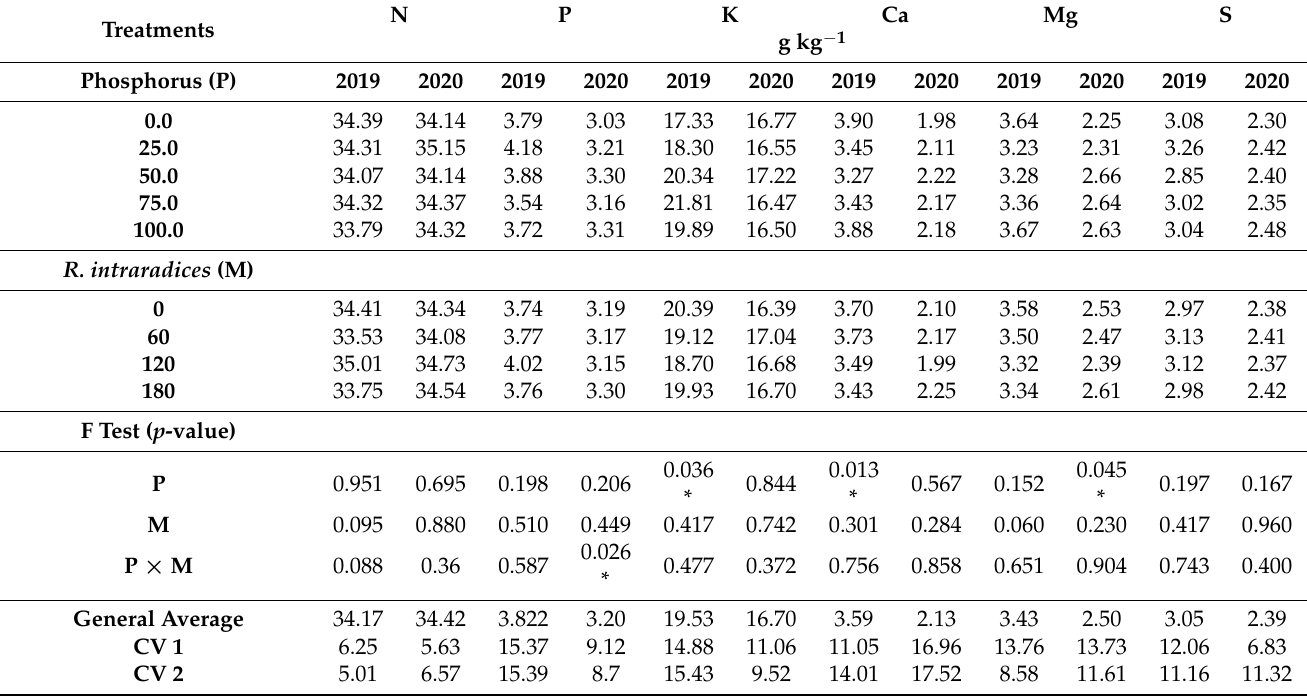
Table 1. Macronutrient foliar contents in corn at flowering as a function of P 2 O 5 doses and seed inoculation with Rhizoglomus intraradices .